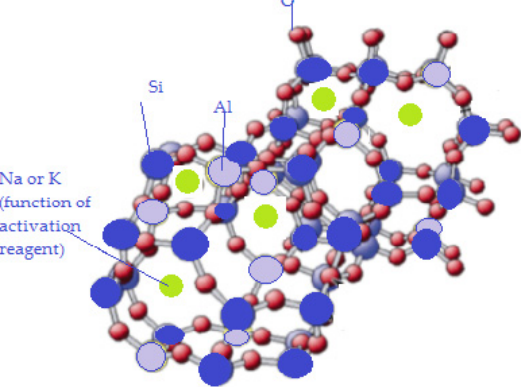
Figure 4. Zeolite precursor formed in the alkali activated process.